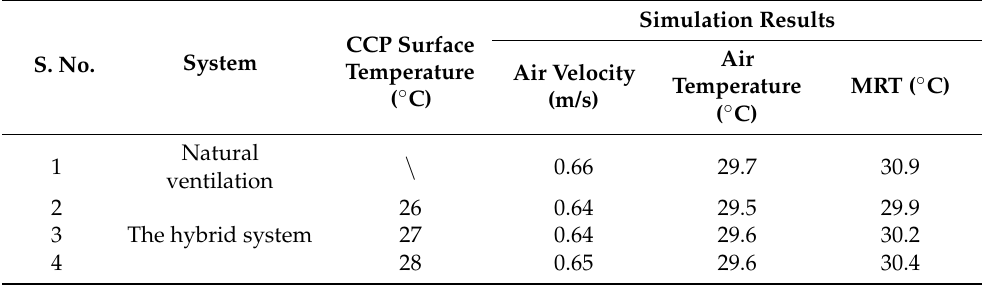
Table 3. Simulation results for the various test cases.